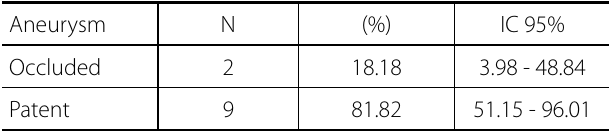
Table 1. Analysis of aneurysm